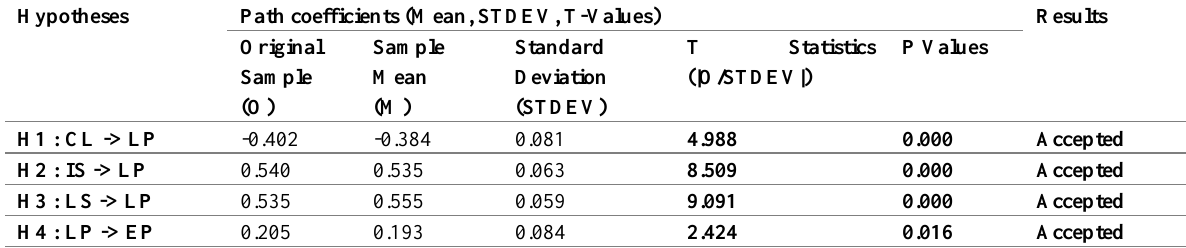
Table 5: Variable Relationship